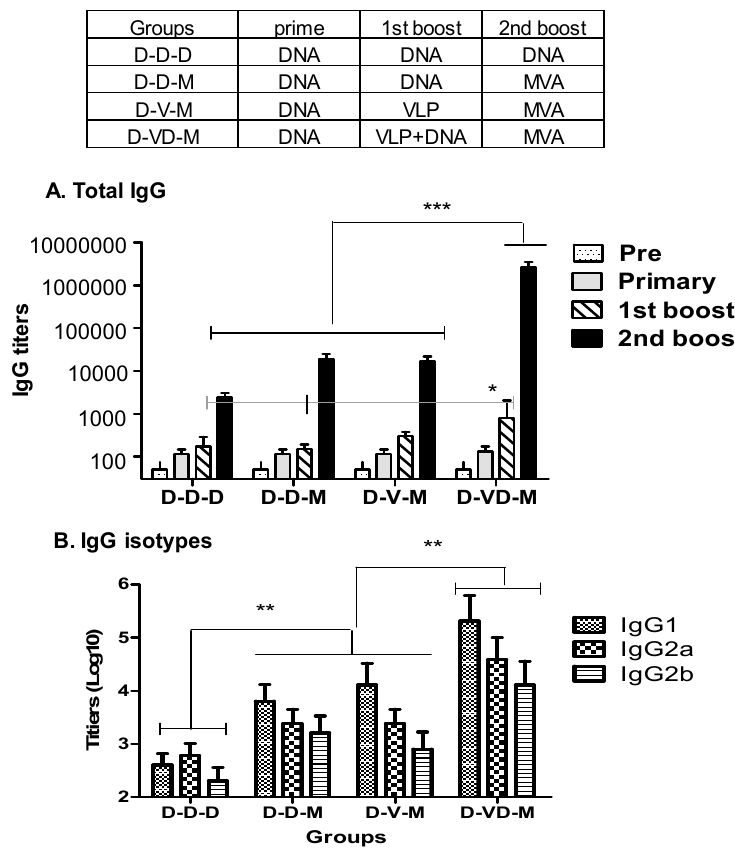
Figure 2. Vaccination groups and HIV-1 Env-specific IgG serum antibody titers. Top paned: Groups of mice ( n = 10) received three sequential subcutaneous immunizations with vaccines by a four-week interval homo or heterologous prime-boost regimen. D-D-D: DNA (50 µg) prime—first boost— second boost with the same dose, D-D-M: DNA (50 µg) prime—DNA (50 µg) first boost—rMVA (1 ×